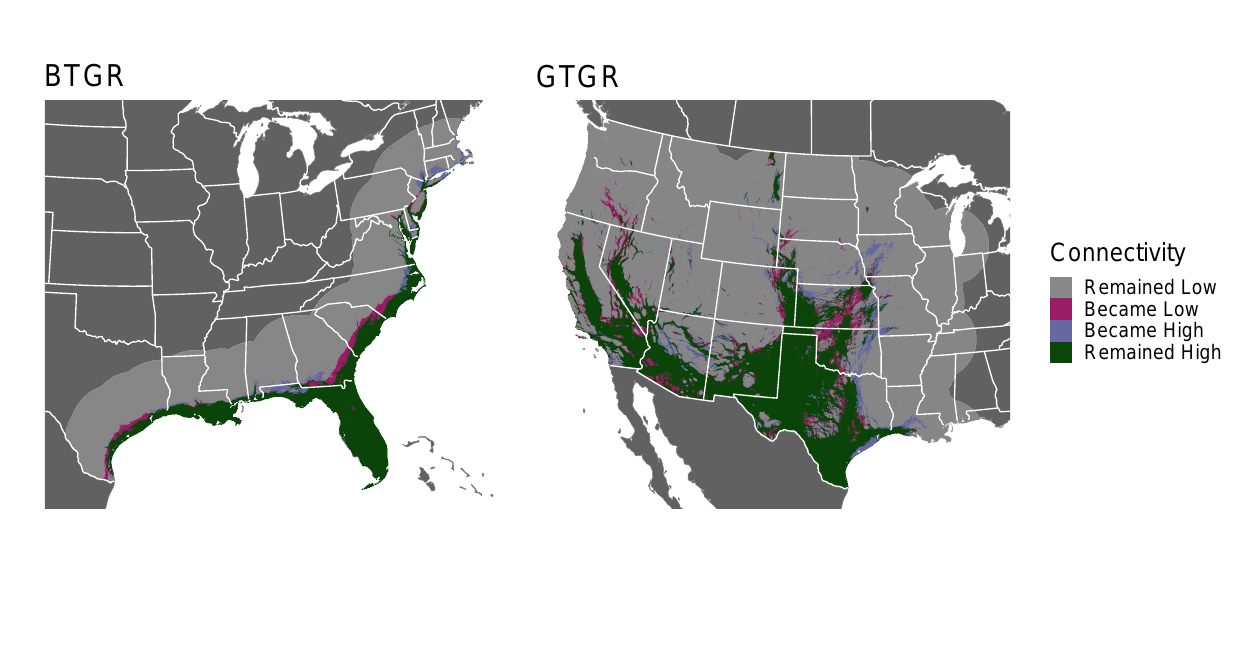
Supplementary Figure 6 – Change in connectivity between 1979 and 2019 measured as change in accumulated current for boat-tailed grackles (BTGR) and great-tailed grackles (GTGR). Current values were divided into high and low categories based on whether the values were above or below the 75th percentile of current values for each map. Colors indicate whether the current values remained low between the two time steps (gray), went from high to low (magenta), went from low to high (blue), or remained high (green). The darker gray color indicates areas outside the range where checklists were selected for each species, and were excluded from the connectivity analysis. The regions that have remained highly connected are continuous for both species, which indicates that changes in connectivity are not responsible for range changes in either